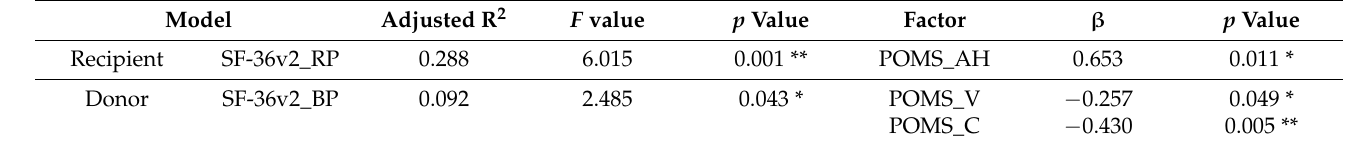
Table 6. Significant impact factors of POMS on choosing between PEKT and PDKT. Multicollinearity was suspected if the VIF value was greater than 10. * p < 0.05, ** p < 0.01: significant effects of POMS scores on the direct impact factors for choosing between PEKT and PDKT among recipients and donors according to stepwise multiple regression analysis with robust standard